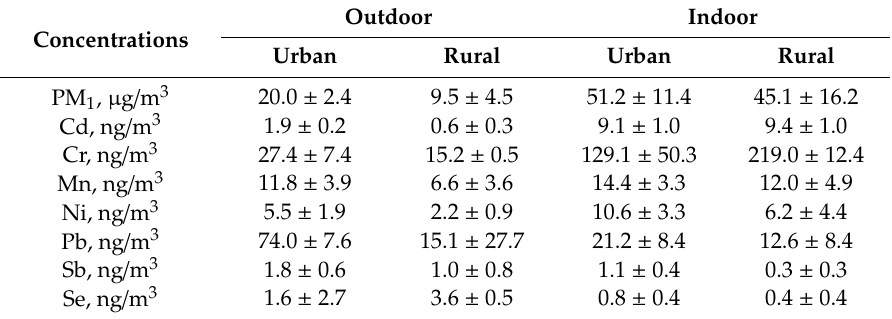
Table 1. Average ± SD concentration of trace elements (ng / m 3 ) in indoor air and outdoor air as well as urban and rural locations (n =